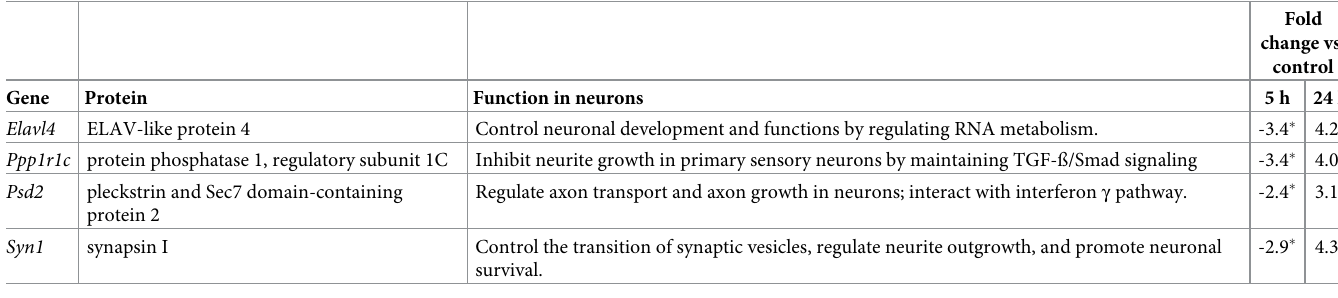
Table 2. Four genes with significant changes at two different time points after kainate treatment.